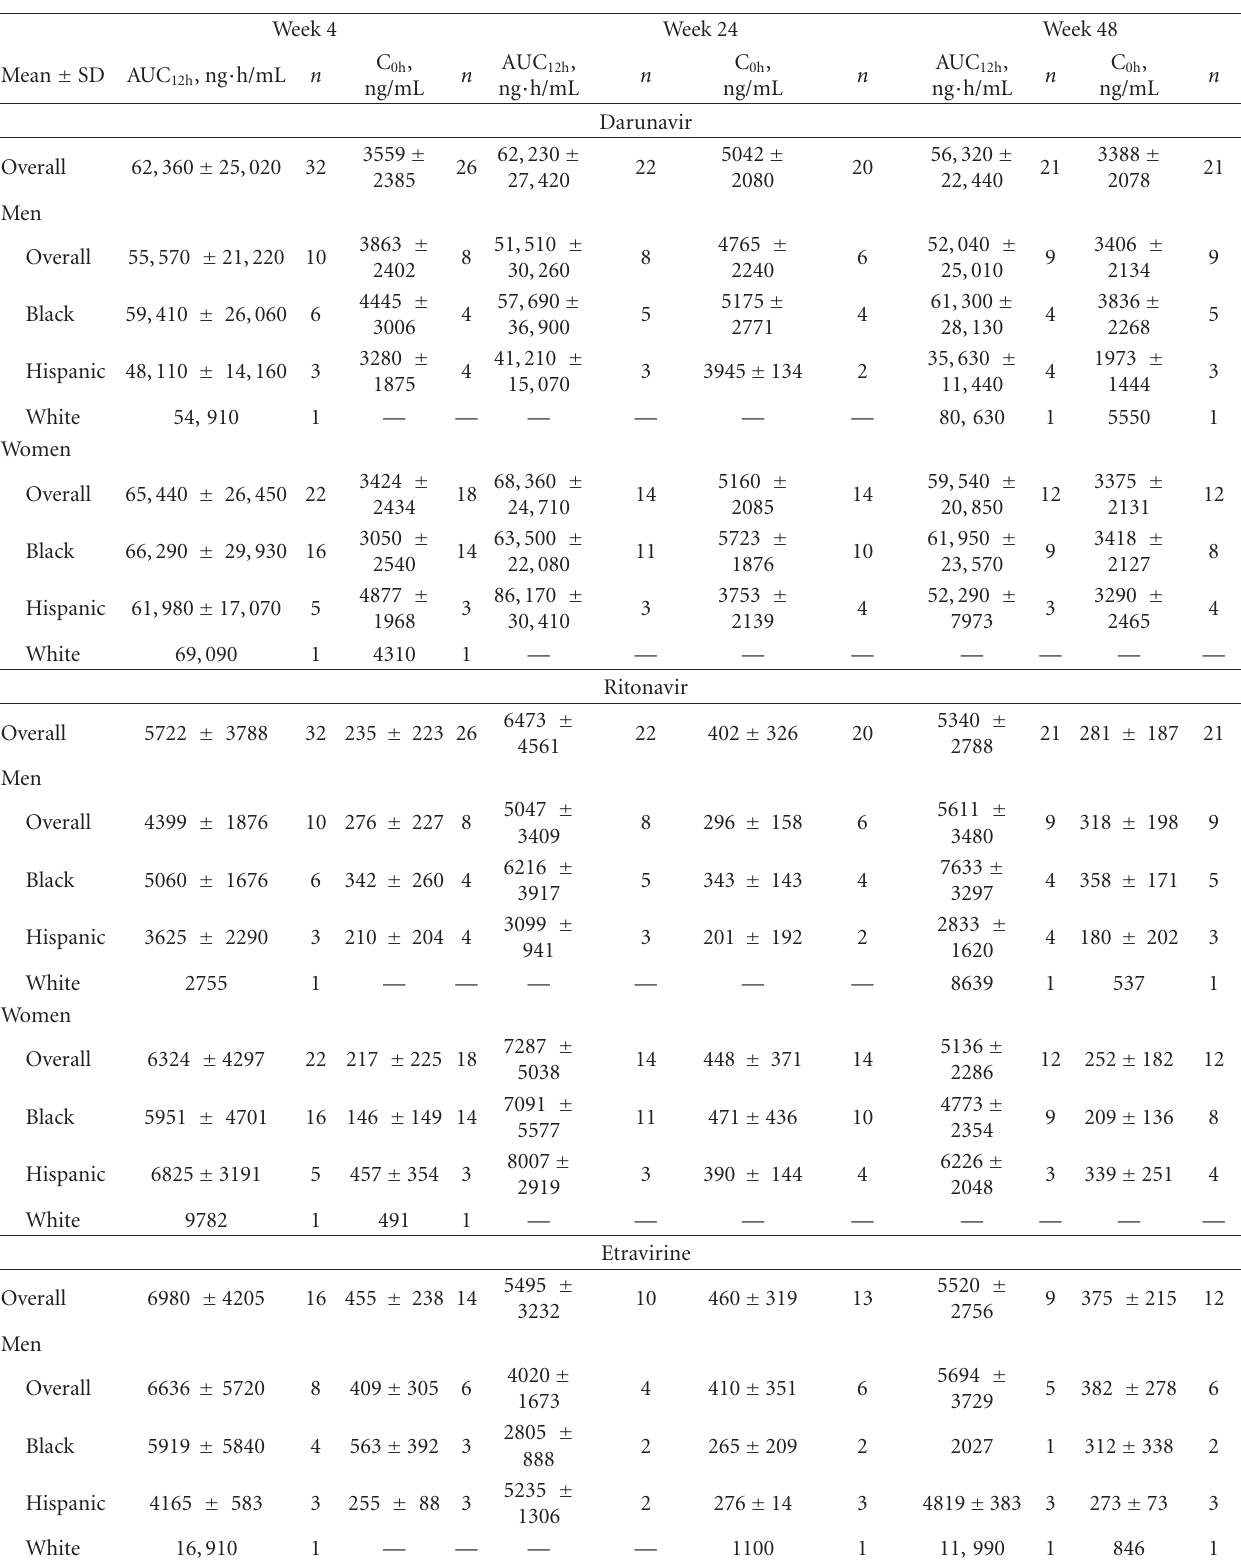
Table 4: Pharmacokinetics of darunavir, ritonavir, and etravirine (intense pharmacokinetic